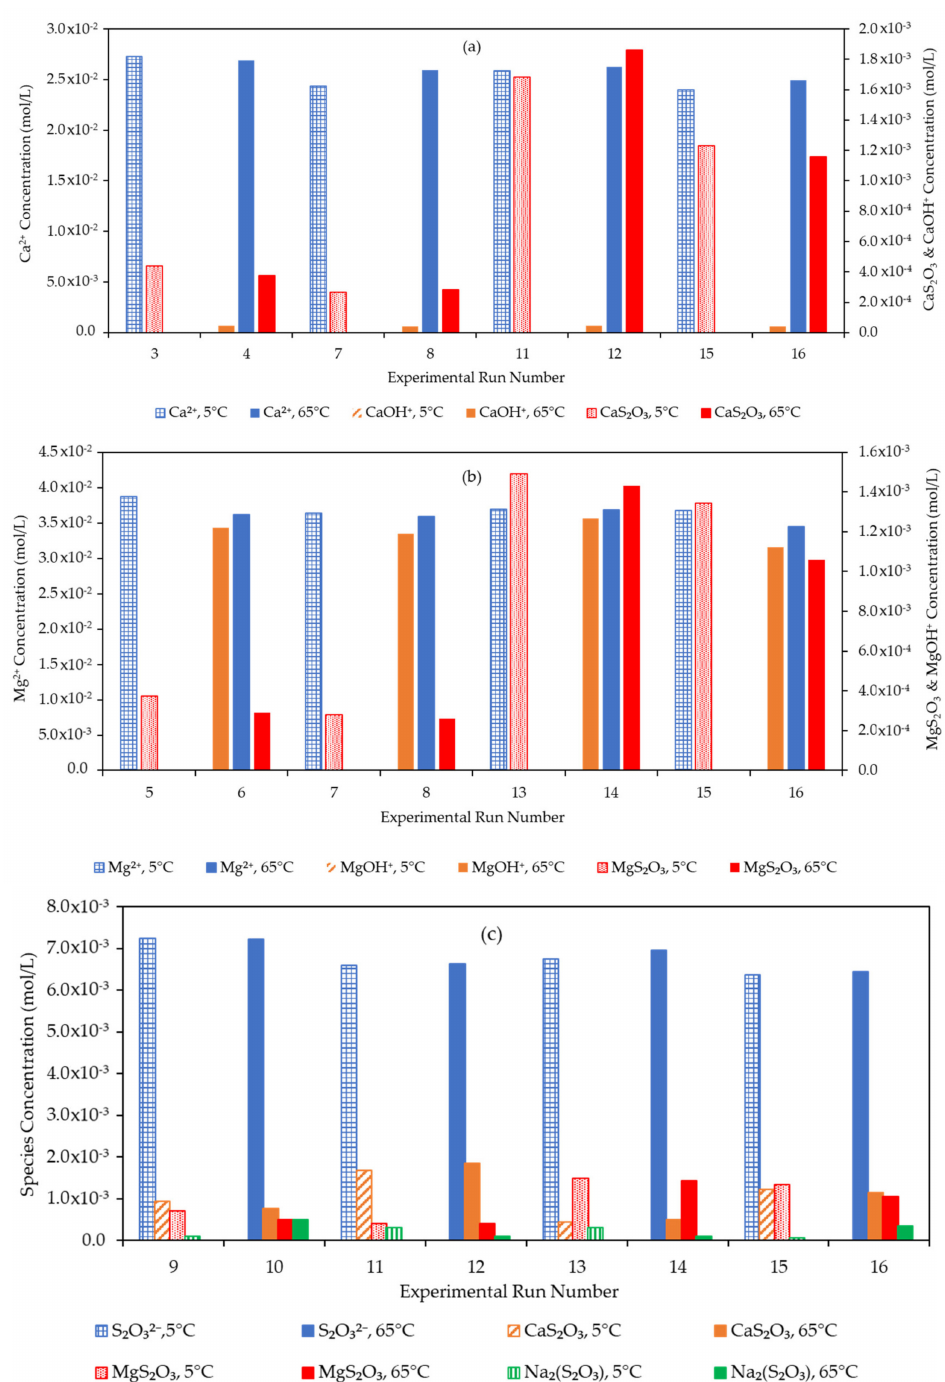
Figure 6. ( a ) Distribution of Ca 2 + after interaction in di ff erent water matrices at pH 9. Starting Ca 2 +